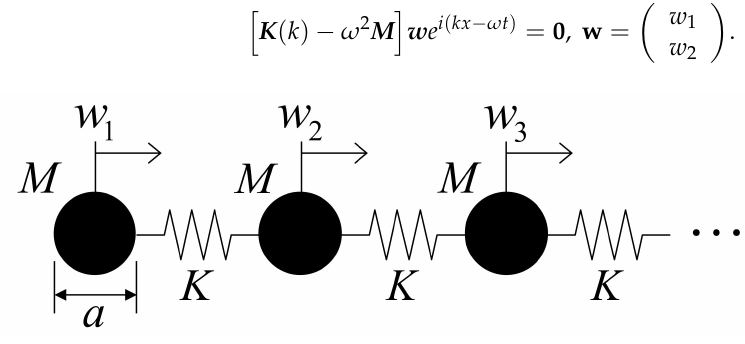
Figure 3. A repeating mass-spring system for longitudinal wave